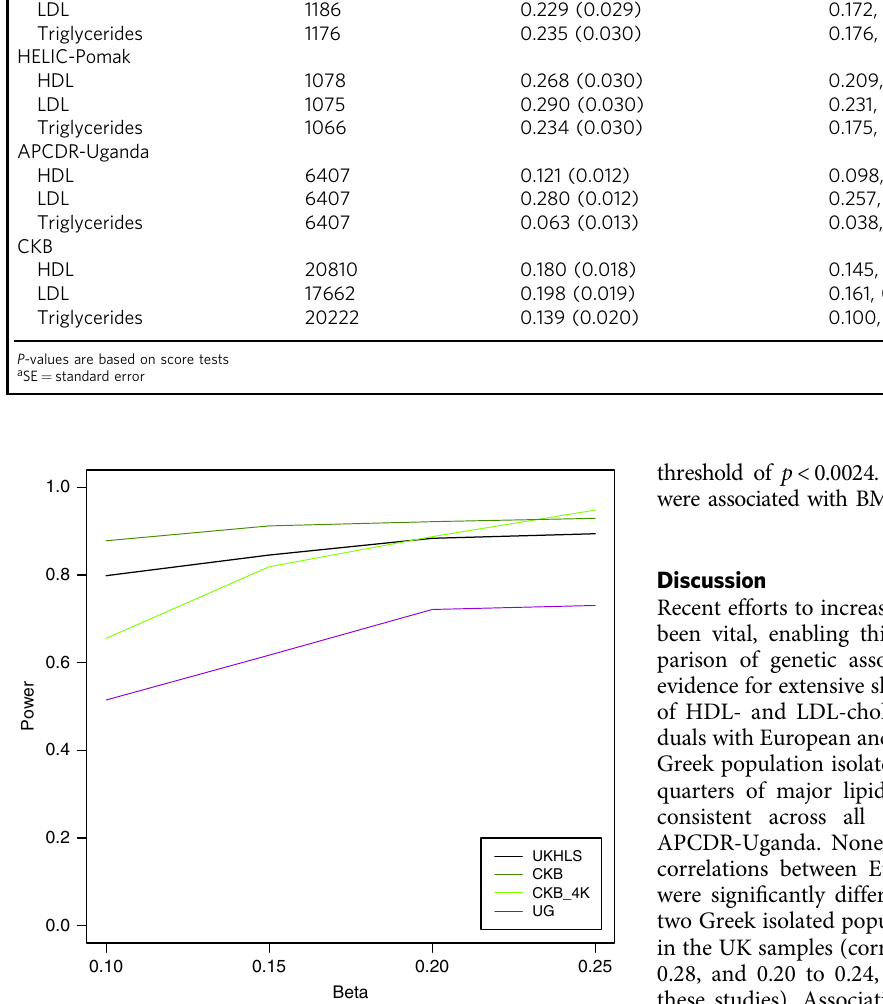
Fig. 3 Power of trans-ethnic colocalization to detect shared associations for different effect sizes (Beta). Based on a simulation study comparing 50,000 samples with European ancestry from UK Biobank to UKHLS, APCDR-Uganda ( “ UG ” ), and China Kadoorie Biobank ( “ CKB ” ). Additionally,